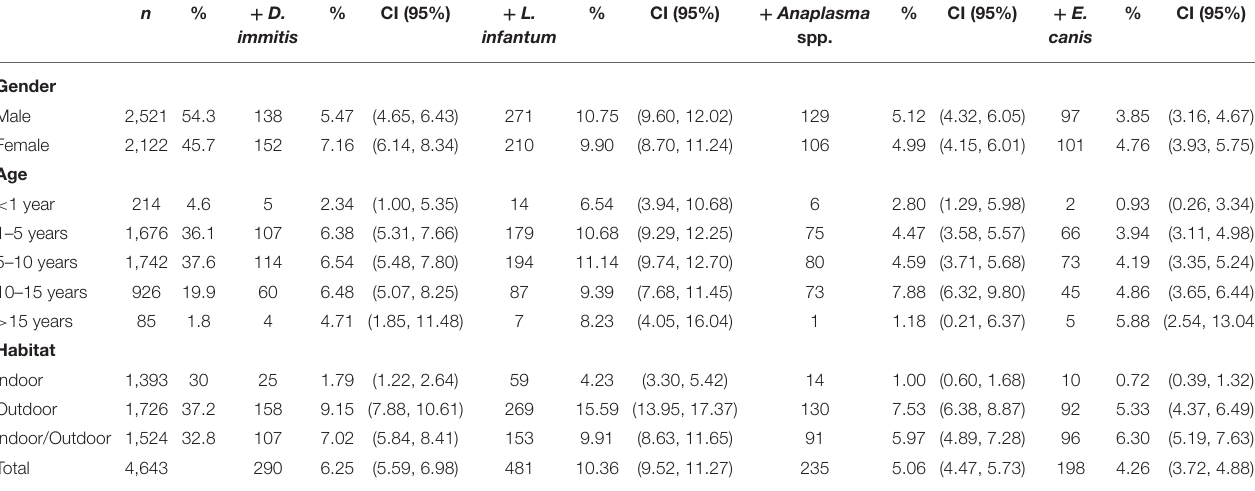
n, number of dogs sampled; + , positive animals; %, percentage of positive